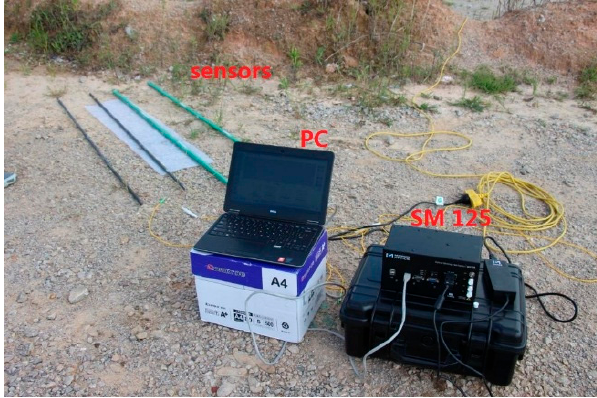
Figure 13. The sensing system incorporating the custom sensors.